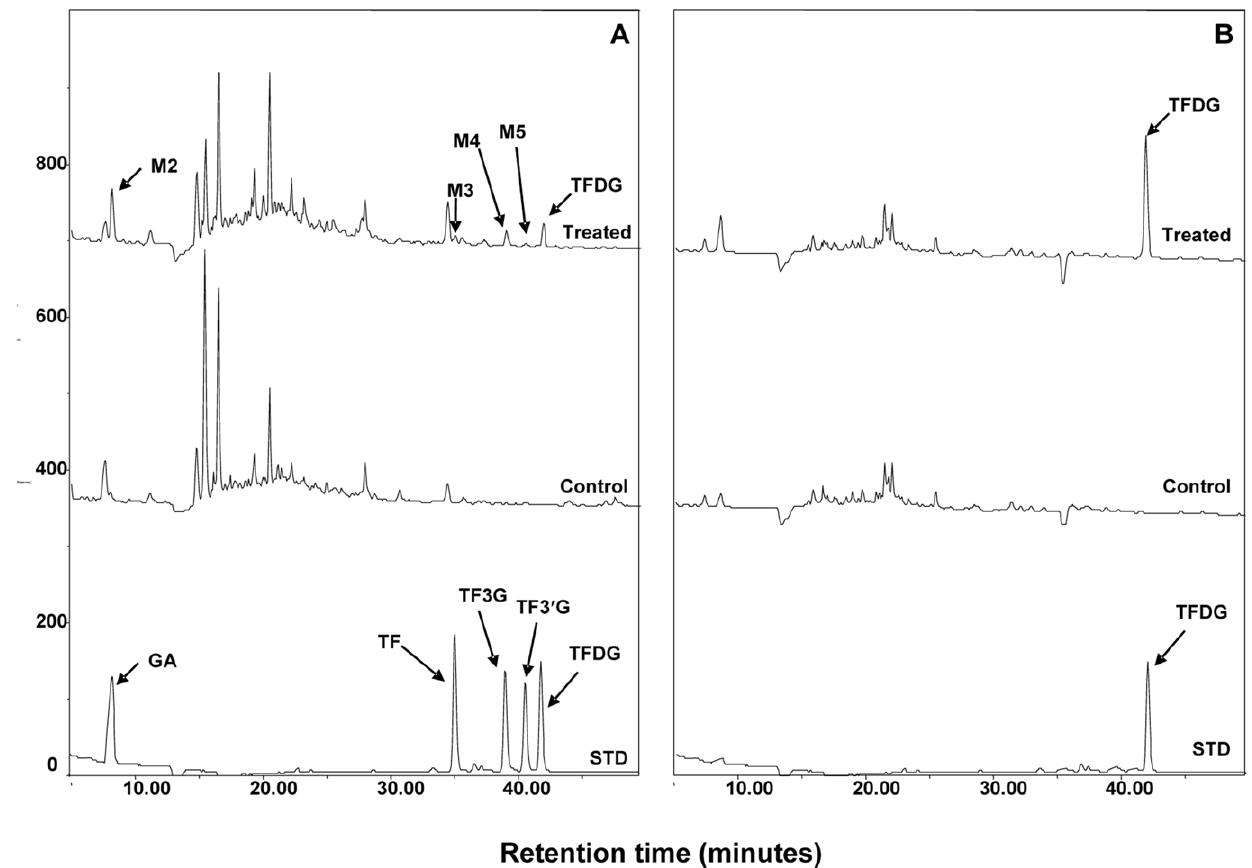
Figure 2. HPLC-ECD chromatograms of fecal samples collected from TFDG (treated, 200 mg/kg, oral gavage) or DMSO (control) treated special pathogen free (SPF) mice (A) and germ-free (GF) mice (B). TFDG: theaflavin 3,3 9 -digallate.